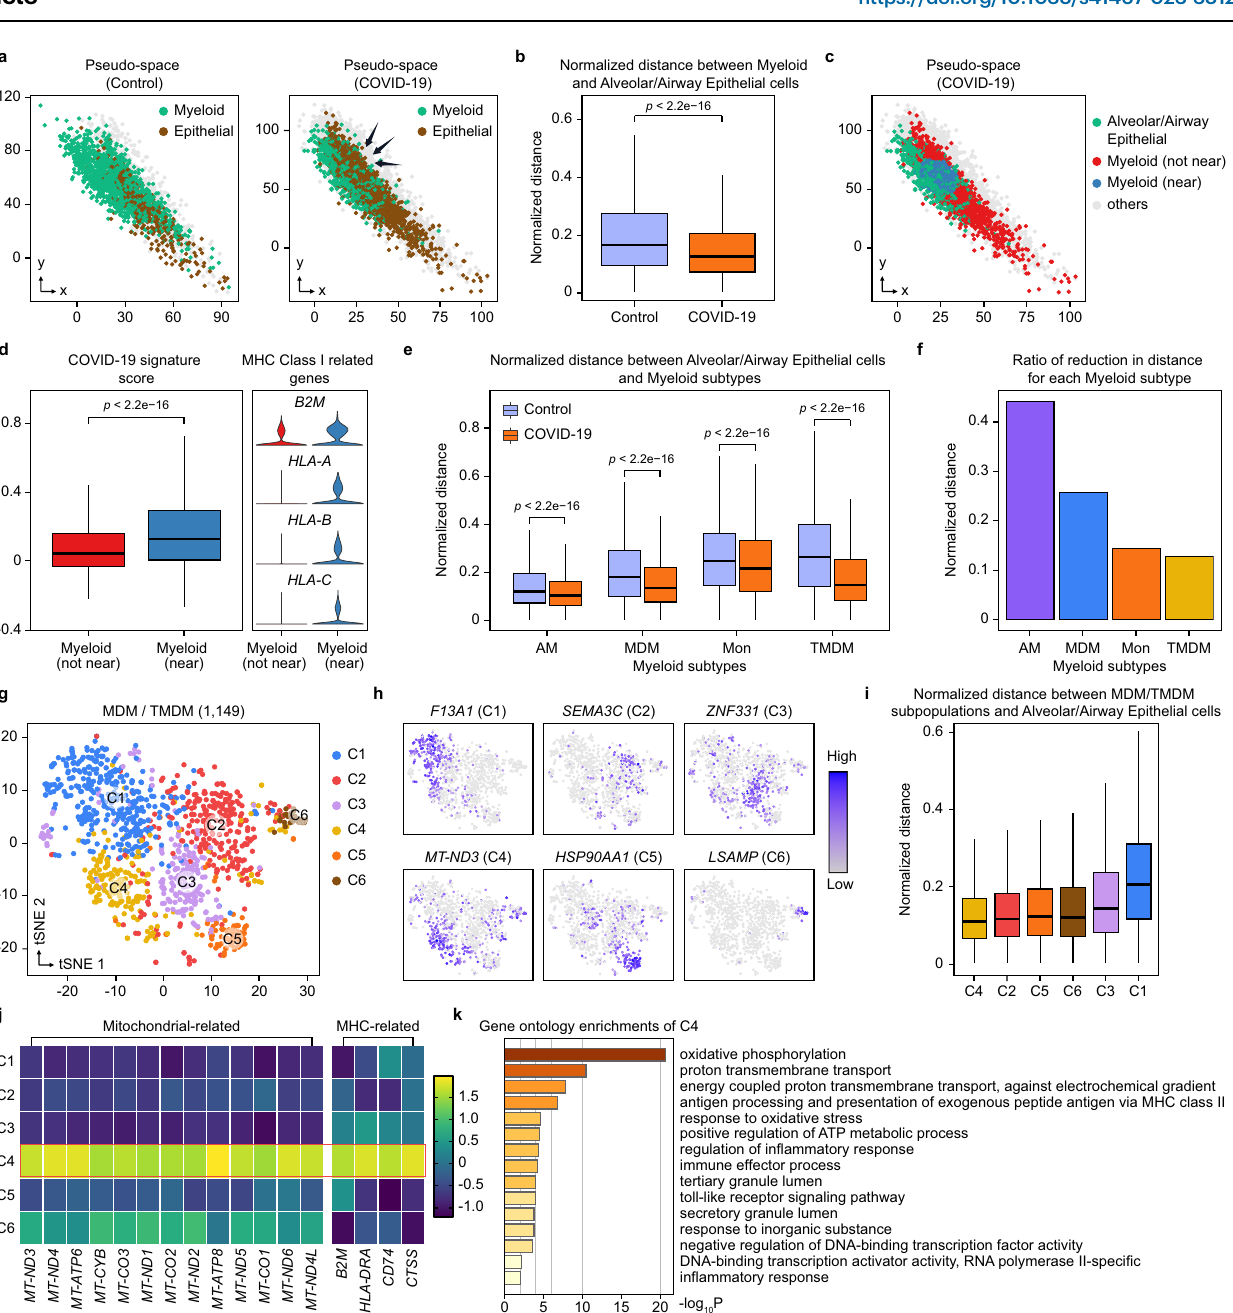
(minima, 25th percentile, median, 75th percentile, and maxima). The number of data points for the control group is 192,705, 237,891, 82,398, and 35,883, respec- tively; the number of data points for the COVID-19 group is 1,017,744, 677,040, 226,044, and 352,716, respectively. P -value is calculated with the two-sided Wil- coxon rank-sum test (the exact P -values from left to right are both 0). f Ratio of reduction in the distance between each myeloid subtype and alveolar/airway epi- thelial cells in the COVID-19 group compared to the control group. g , t-SNE visualization of six MDM/TMDM subpopulations identi fi ed by scSpace. h , Feature plot of differentially expressed genes for six MDM/TMDM subpopulations. i NormalizedpairwisedistancebetweenMDM/TMDMsubpopulationsandalveolar/ airway epithelial cells. Data are presented as boxplots (minima, 25th percentile, median, 75th percentile, and maxima). The number of data pointsforthe boxplots from left to right are 450,306, 704,511, 191,259, 79,893, 476,937, and 878,823, respectively. j Scaledaveragedexpressionlevelofmitochondrial-relatedandMHC- related genes in six MDM/TMDM subpopulations. k Signi fi cantly enriched gene ontology (GO) pathway terms for the differentially expressed genes of the C4 subpopulation. P -value is calculated with the hypergeometric